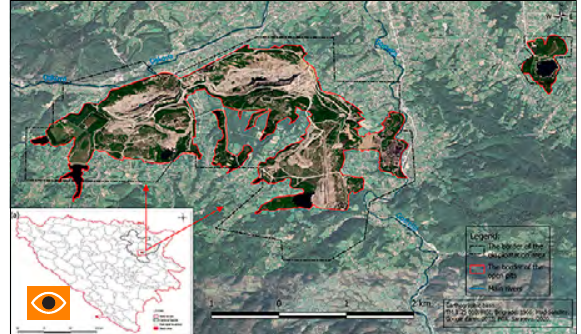
Figure 1. Location of the study area in Bosnia and Herzegovina (a) and the study area